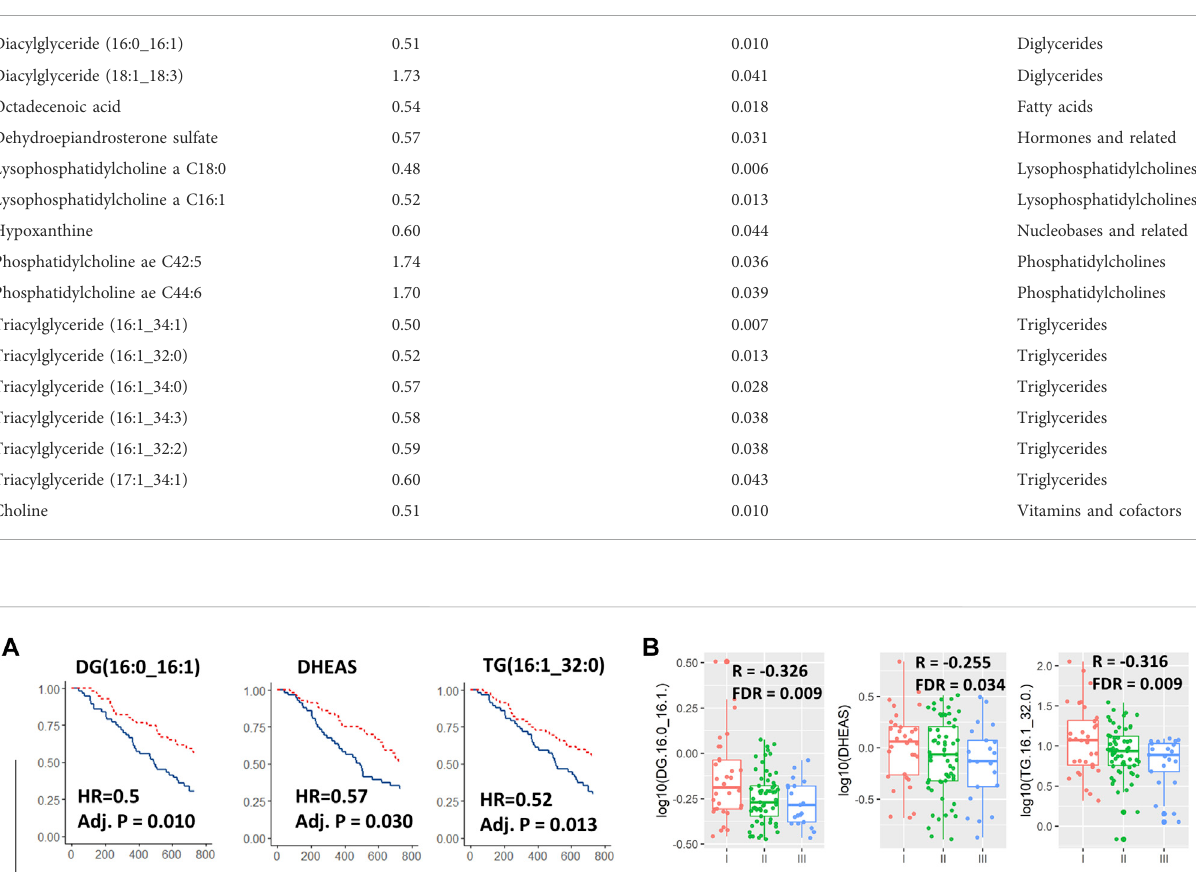
TABLE 2 List of analytes signi fi cantly associated with the 2 years composite endpoint of FVC decline > 10%, DLCO decline > 15% or death. Analyte